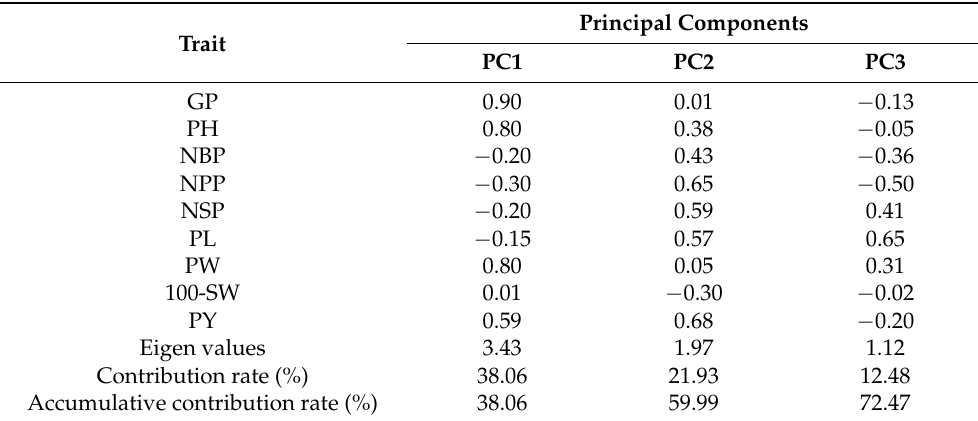
Table 5. Principal component analysis of cowpea traits.